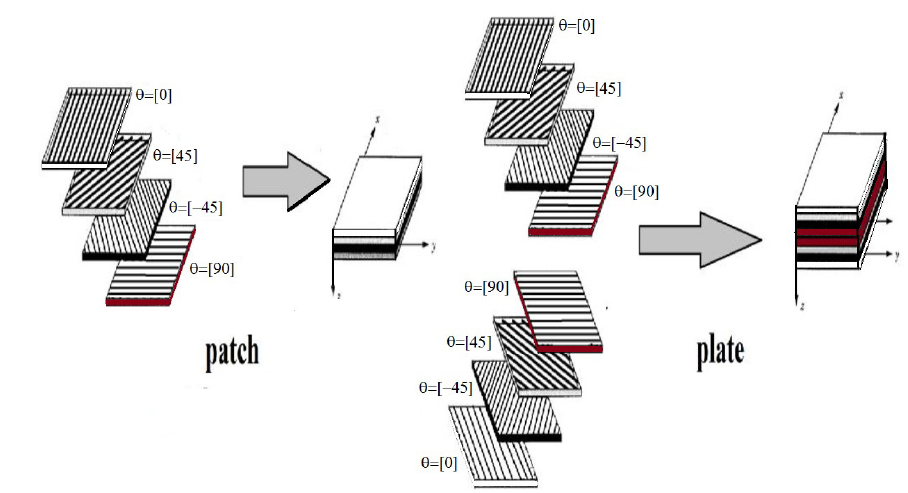
Figure 3. Plies orientation in the patch and